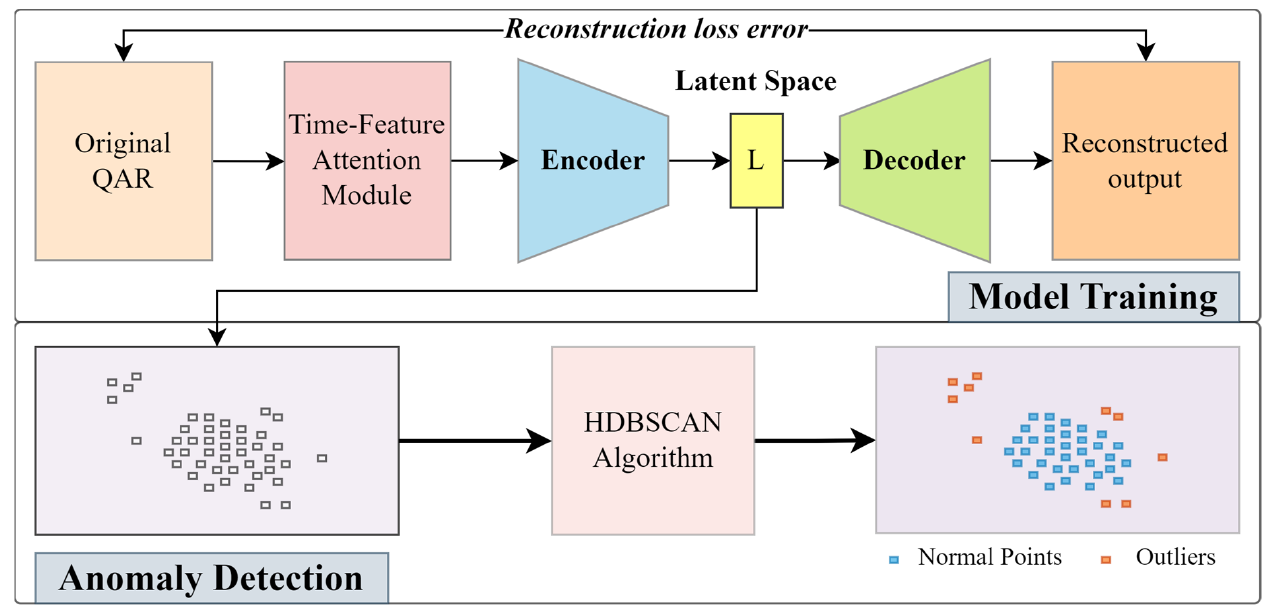
Figure 1. Overview of the proposed deep hybrid model for flight anomaly detection.